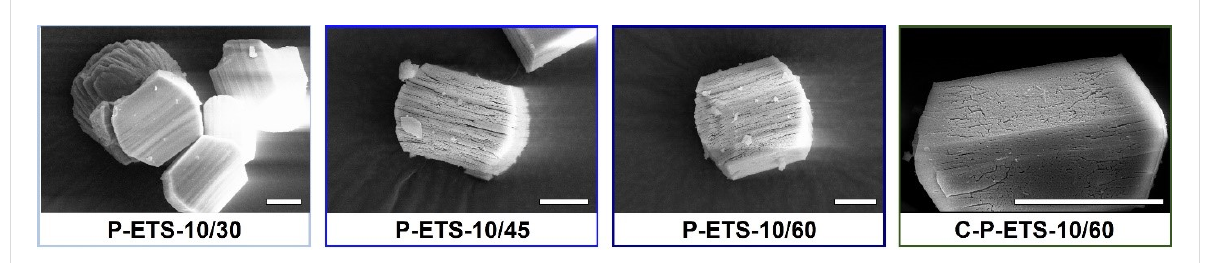
Figure 8: SEM micrographs of the titanosilicates treated with H 2 O 2 for 30, 45 and 60 min (P-ETS-10/30, P-ETS-10/45, P-ETS-10/60). P-ETS-10/60 additionally underwent calcination at 873 K for 6 h. The scale bar in all images is 10 μ m.